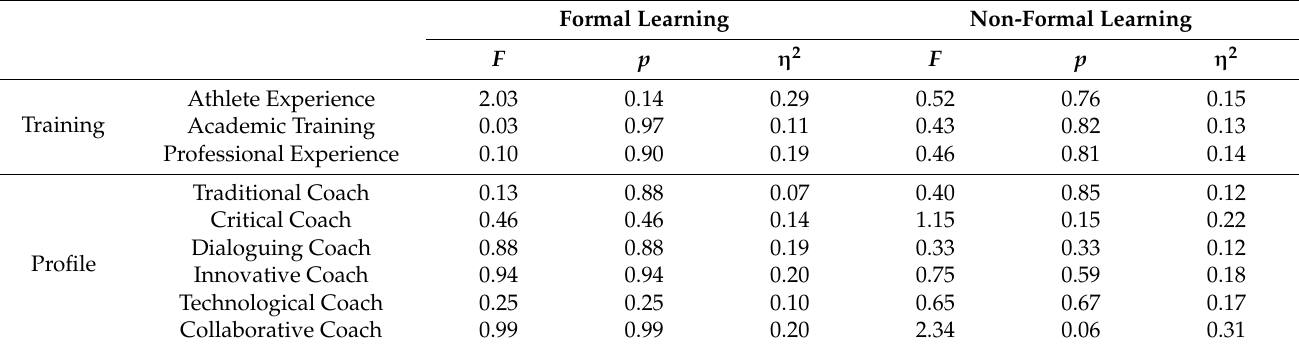
Table 3. Results of the analysis of the differences between training and SOPC